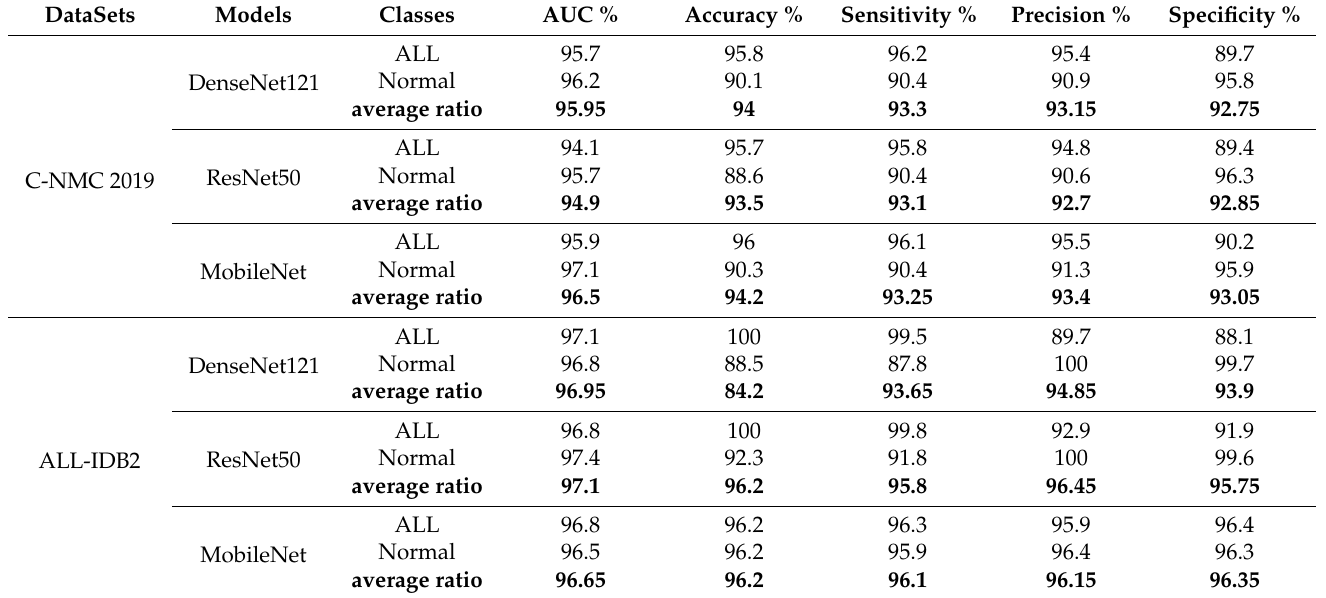
Table 5. Results of CNN models based on segmentation WBC of C-NMC 2019 and ALL-IDB2 datasets for acute leukemia